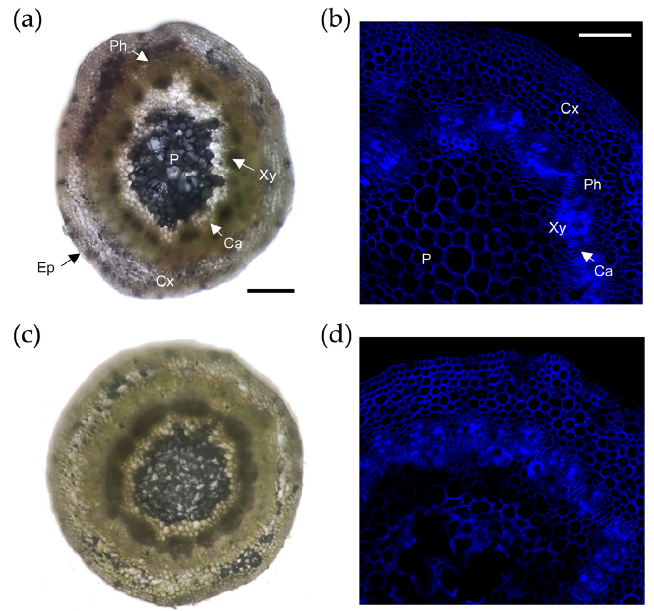
Figure 2. Histological comparison between Garnem and GF 677 microcuttings. No structural differences were observed between Garnem ( a , b ) and GF 677 ( c , d ) tissue microcuttings before AR formation. Scale bar 200 µM ( a , c ) and 100 µM ( b , d ). Cx, cortex; Ph, phloem; Ca, cambium; Xy, xylem; P, pith; and Ep, epidermis.